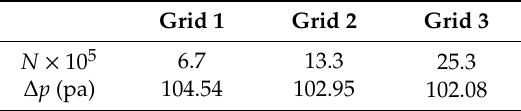
Figure 5. The hybrid grid used in this study. Table 1. Pressure drop under a different number of cells.